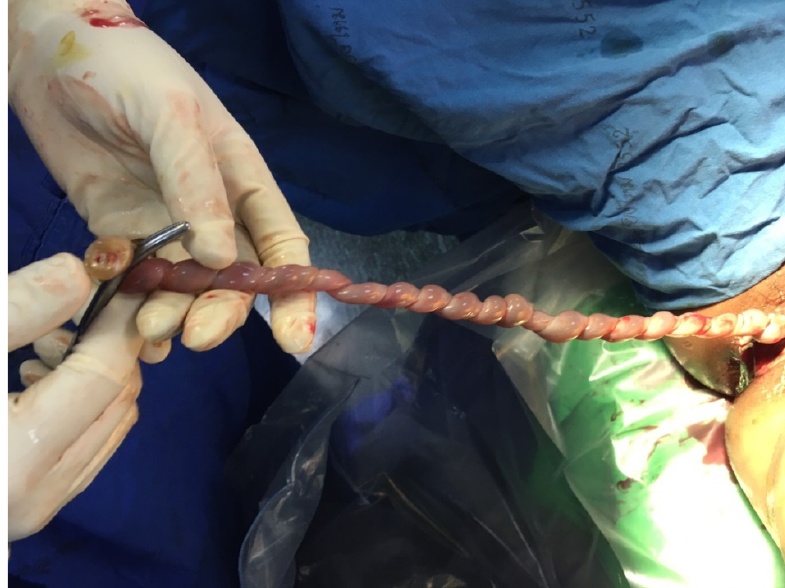
Figure 3. Postnatal finding shows hypercoiled umbilical cord.